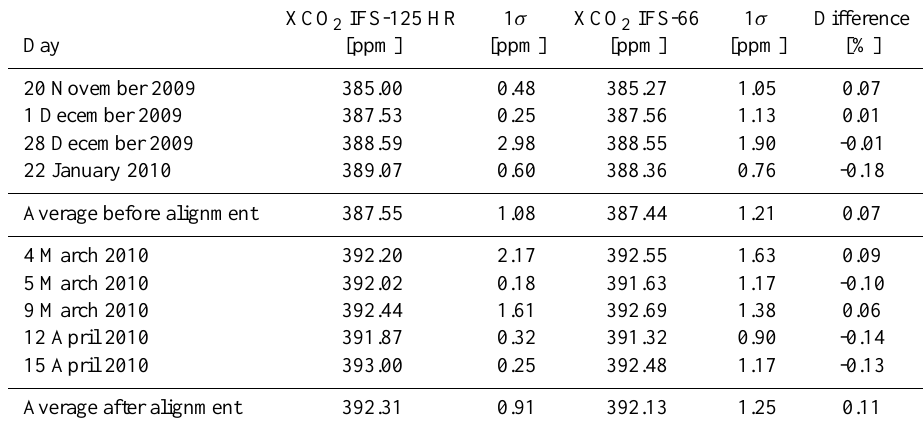
Table 2. Daily means of XCO 2 for nine measuring days. The daily means are calculated from single measurements as a weighted mean, weighted to the reciprocal of their error variance. As an estimation for the error of the daily means the standard deviation, σ , is given. The differences of the daily means are given in percent while the averages of differences are calculated from the absolute values.